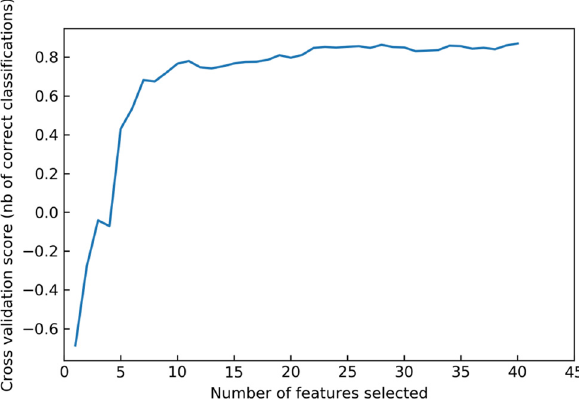
Figure 4: Selection of the best number of